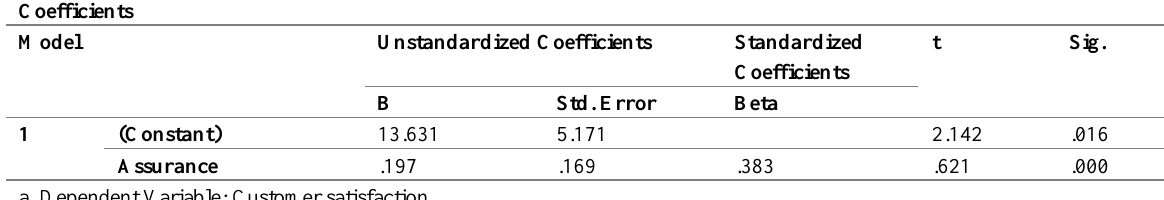
Table 13: Hypothesis Test Relationship between Assurance and Customer Satisfaction